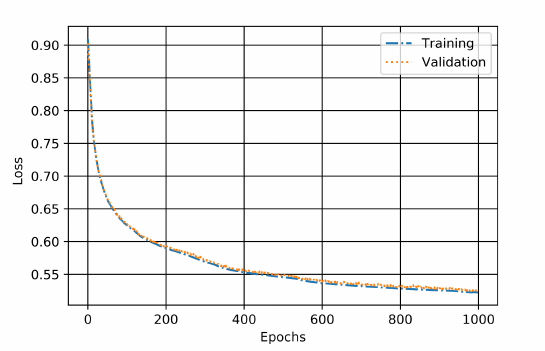
Figure 5. Learning curve of the BDLSTM model with n =